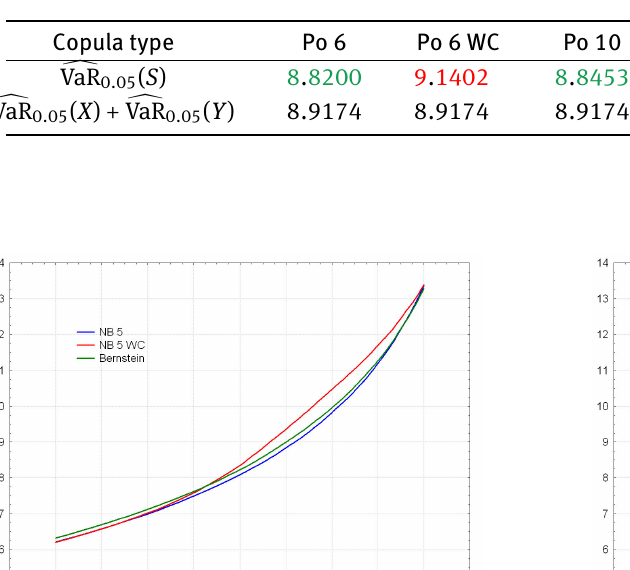
Table 3: Estimates based on Monte Carlo simulations. Poisson copula approaches